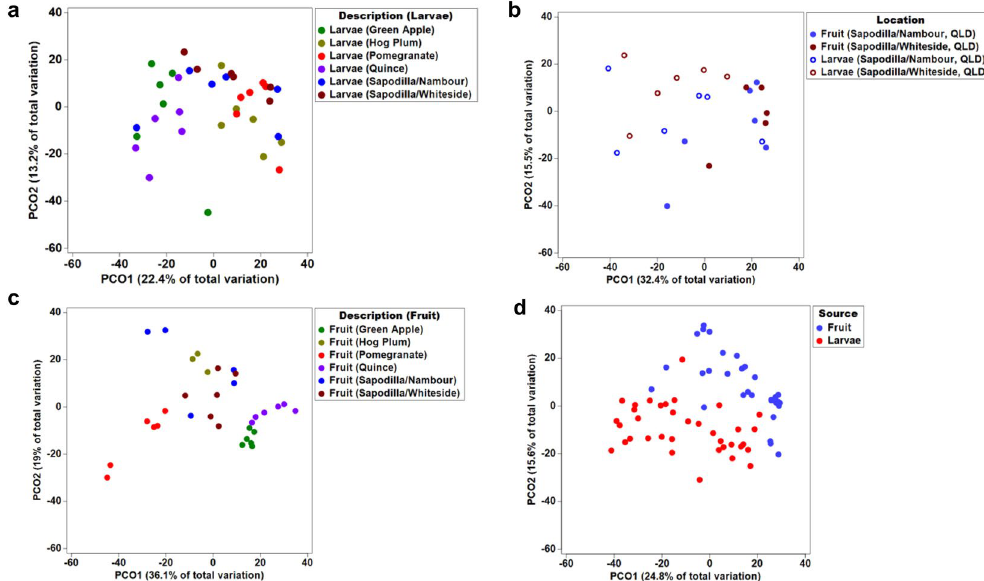
Figure 3. Principal co-ordinate analysis ( a ) the larval gut bacteria of B. tryoni from five type of fruit sources ; ( b ) Bacterial community composition of the B. tryoni larvae collected from 2 different location (Sapodilla); ( c ) Bacterial community composition in the five different fruit; ( d ) bacterial population between larvae and fruit. Different color point indicates different fruit type and the larvae respectively.